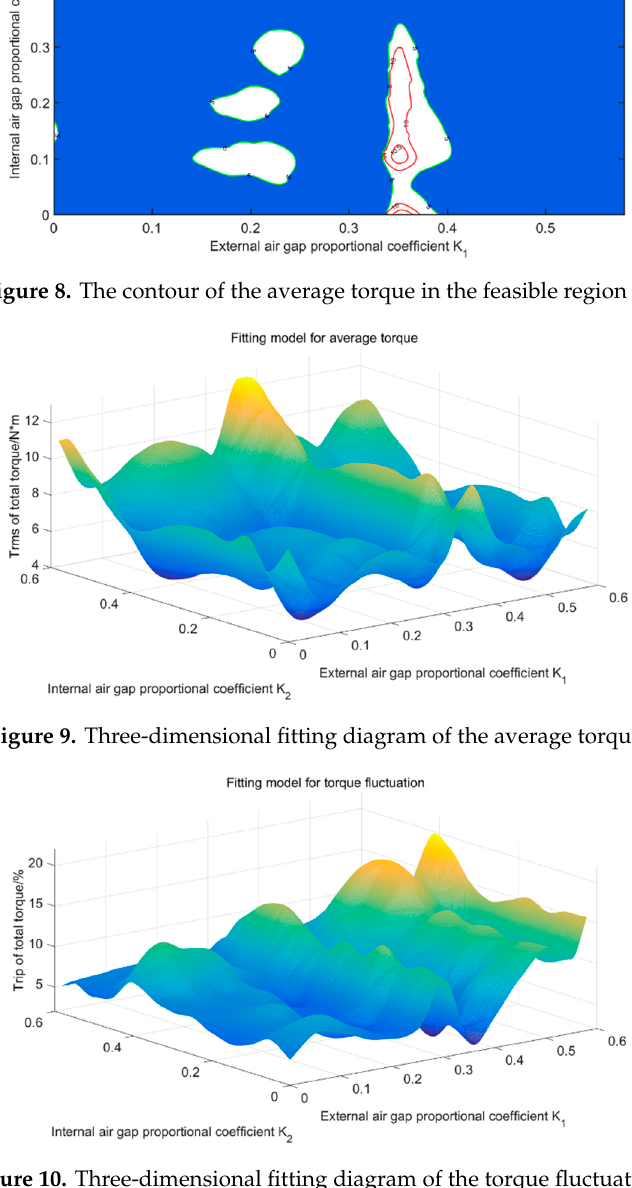
Figure 10. The contour of the average torque in the feasible region X. (3) Get the optimal solution. The maximum value